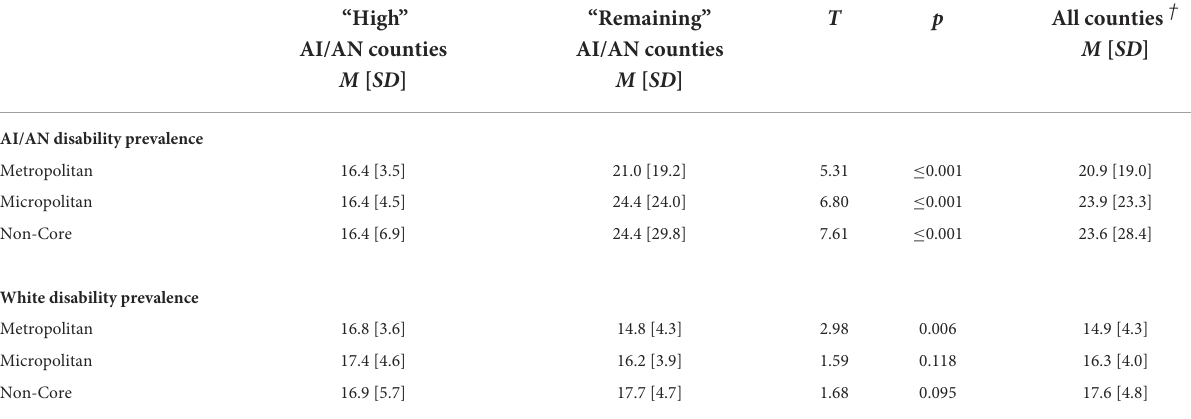
TABLE 1 T -test comparisons of disability prevalence among AI/ANs and Whites in “high” vs. “remaining” AI/AN counties * . “High”